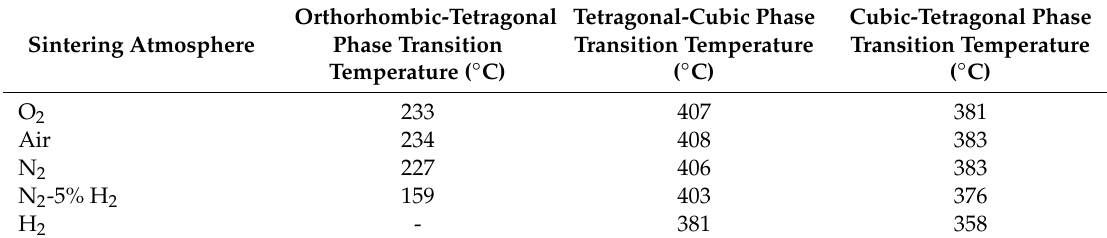
Table 2. DTA phase transition temperatures of KNbO 3 samples sintered at 1040 ◦ C for 3 h in di ff erent atmospheres.